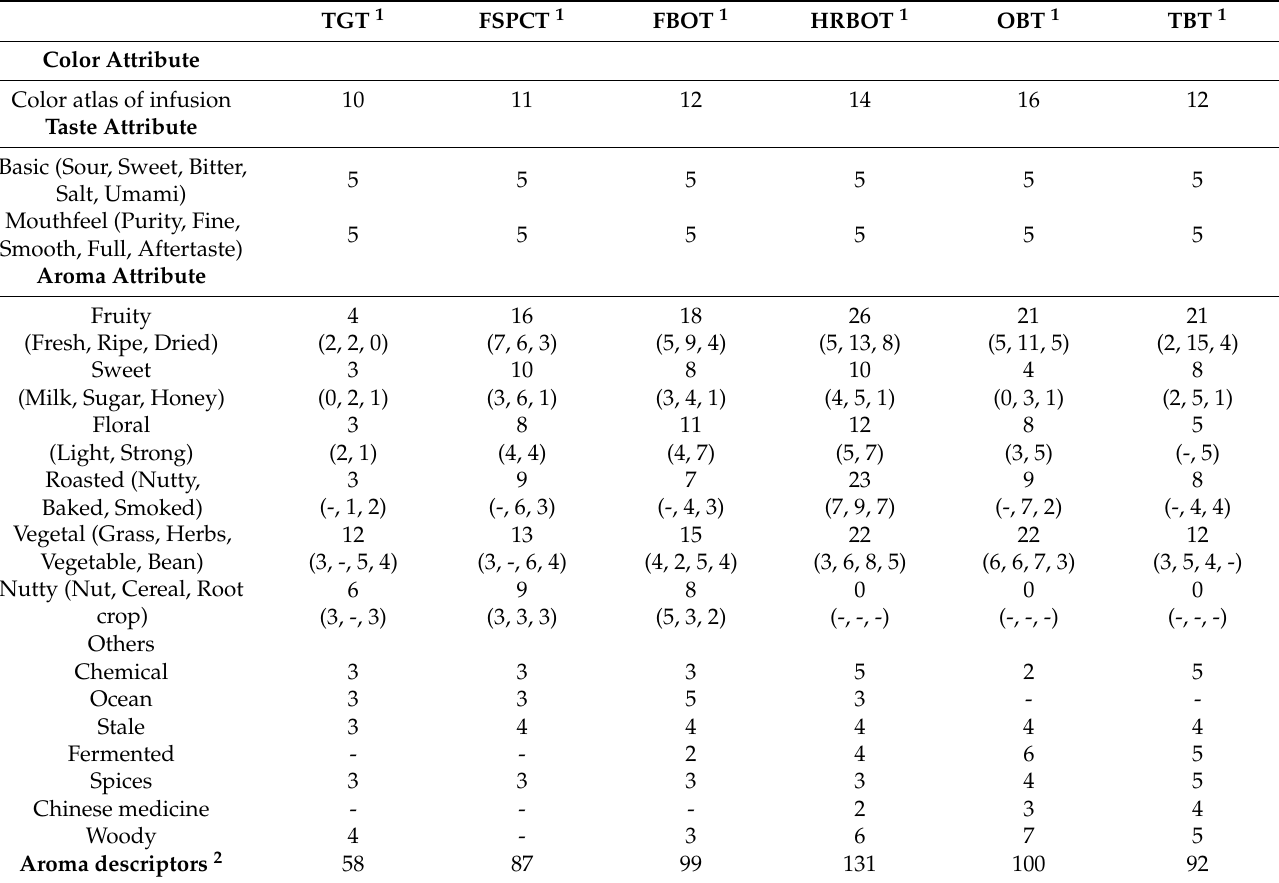
Table 2. Development of the lexicons used in six sensory wheels to characterize the flavor perceptions of experts and consumers for Taiwan specialty tea